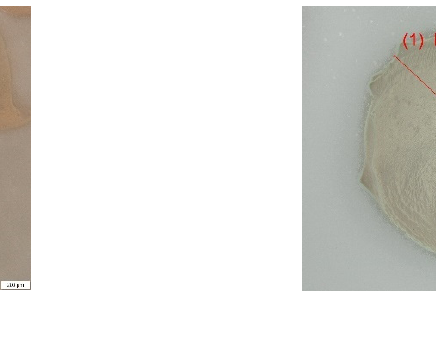
Figure 7. Optical microscopy analysis for ALG microbeads: ( a ) 50× and ( b ) 100× magnification.